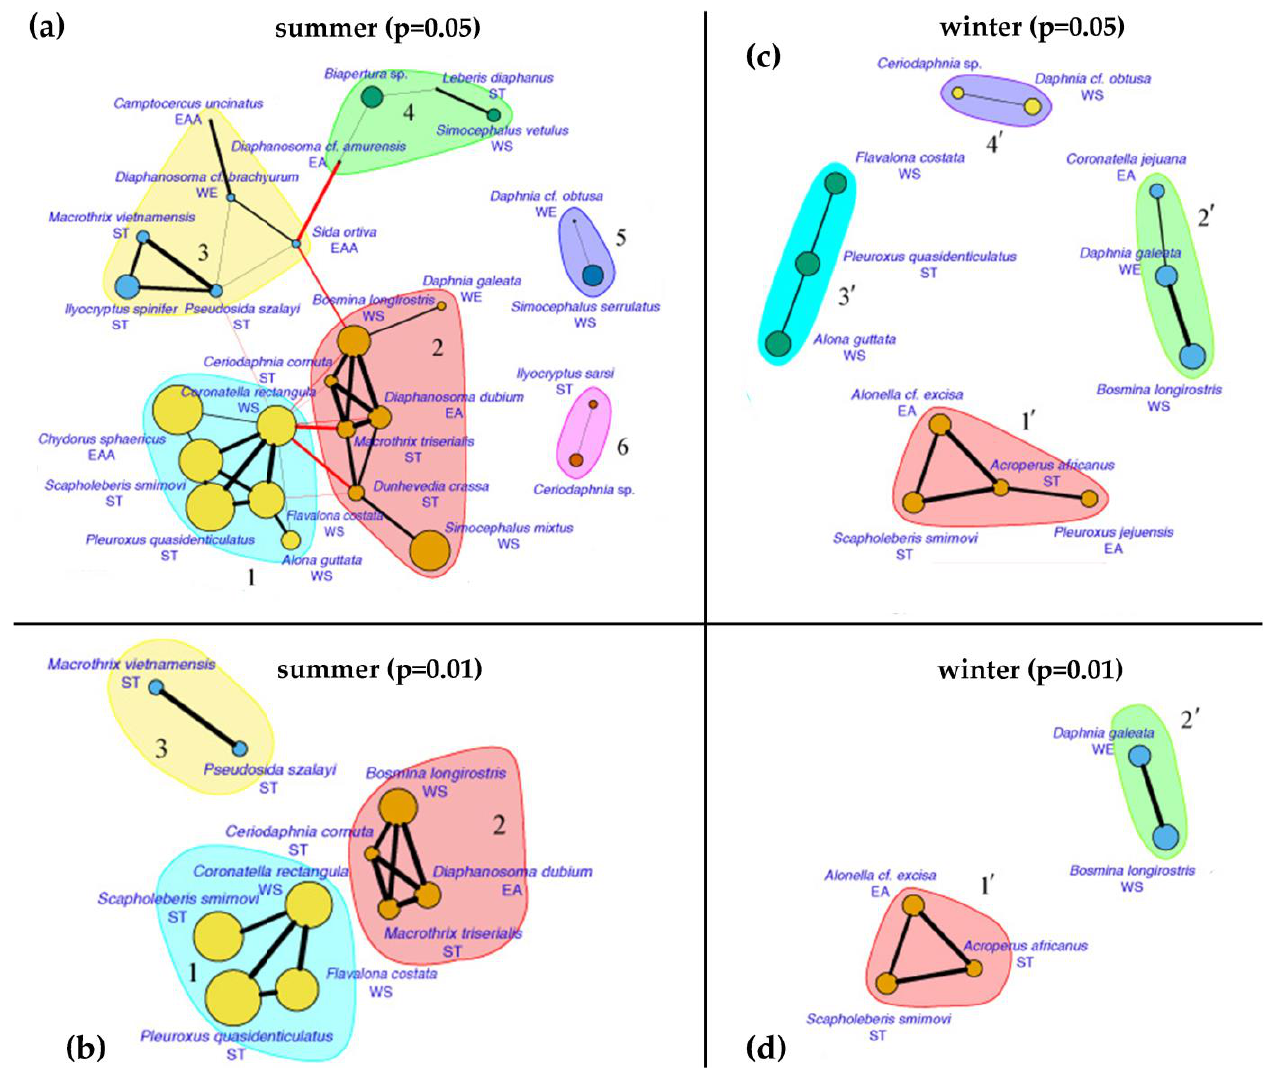
Figure 6. Clusters of positively associated cladoceran species: ( a ) in summer ( p = 0.05); ( b ) in summer ( p = 0.01); ( c ) in winter ( p = 0.05); ( d ) in winter ( p = 0.01). The node size is proportional to the frequency of the species occurrence. Internode thickness is proportional to association strength.